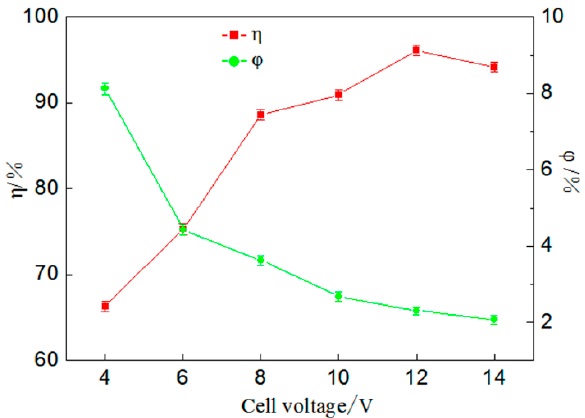
Figure 4. Influence of cell voltage on percentage of gold deposition ( η ) and coulombic efficiency( φ ).